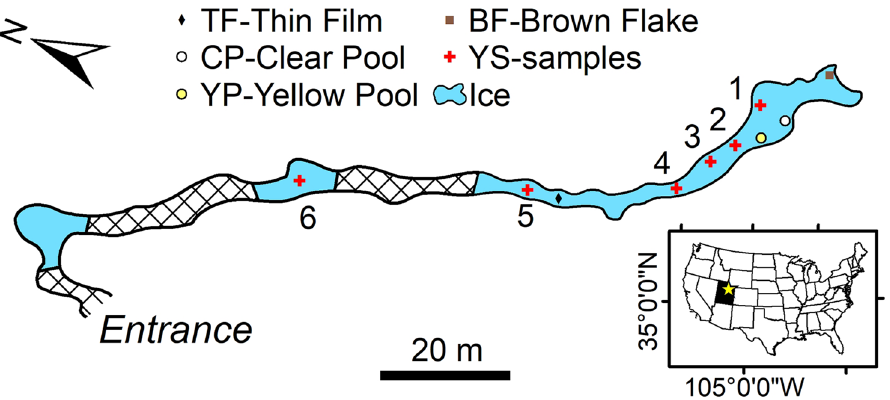
Figure 1. Map of Winter Wonderland Cave showing sections of the cave floored by ice (blue), breakdown (hatched pattern), and sampling locations. Inset shows the location of the cave in northeastern Utah